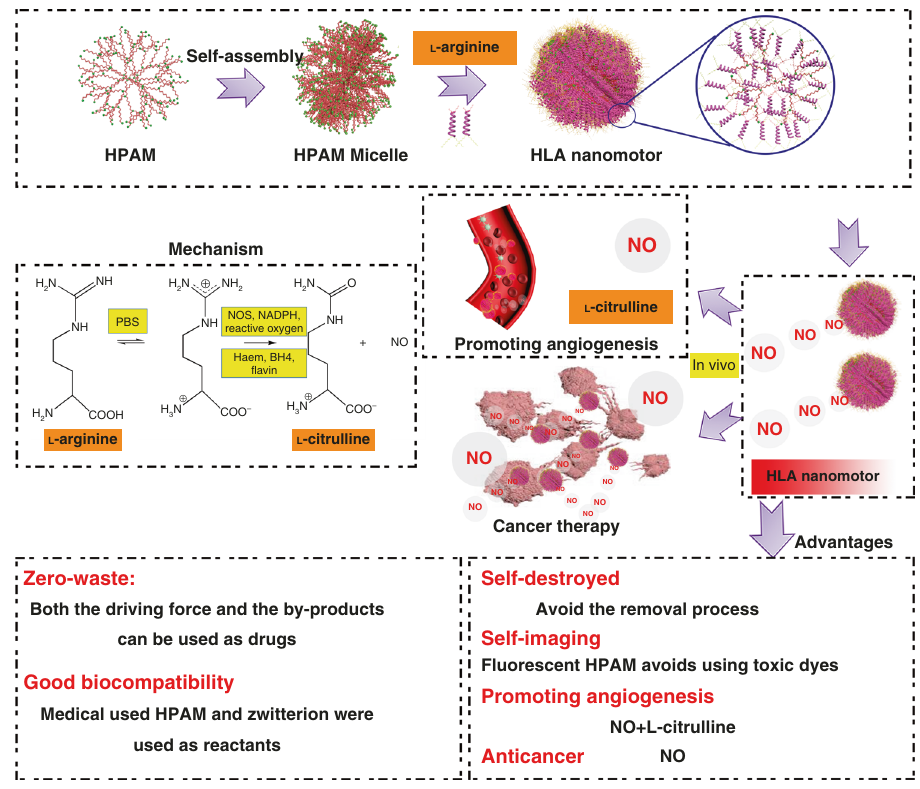
Fig. 1 Schemetic illustration of the formation of zwitterion-based nanomotor and the NO generation